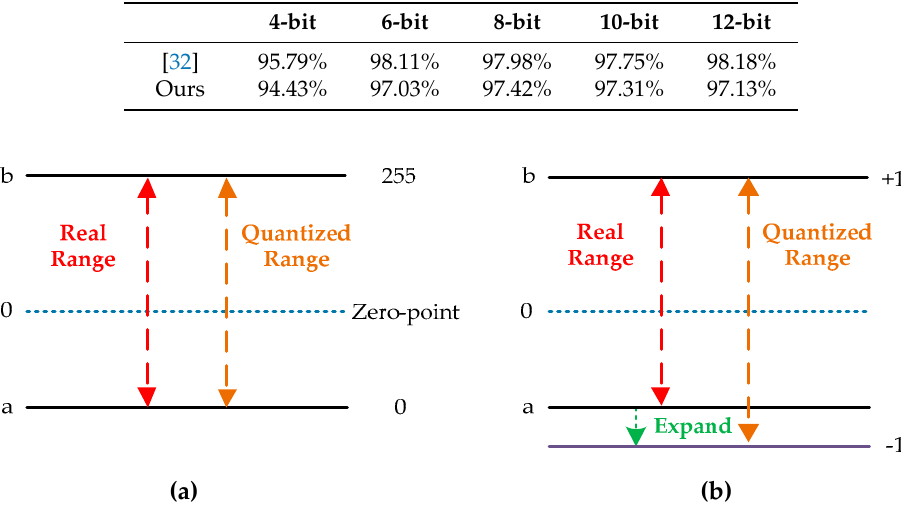
Figure 10. ( a ) Real dynamic range and quantized range in [32].( b ) Real dynamic range and quantized range in ours.